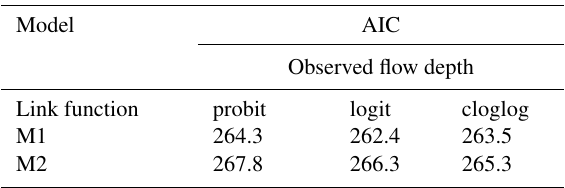
Table 9. AIC values for the two models fitted to the observed flow depth of